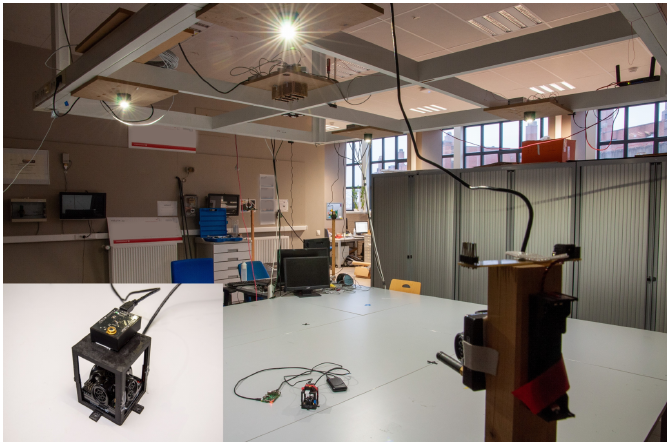
Figure 3. A photo of the complete experimental set-up with four light-emitting diodes (LEDs) at height h = 1.284m.